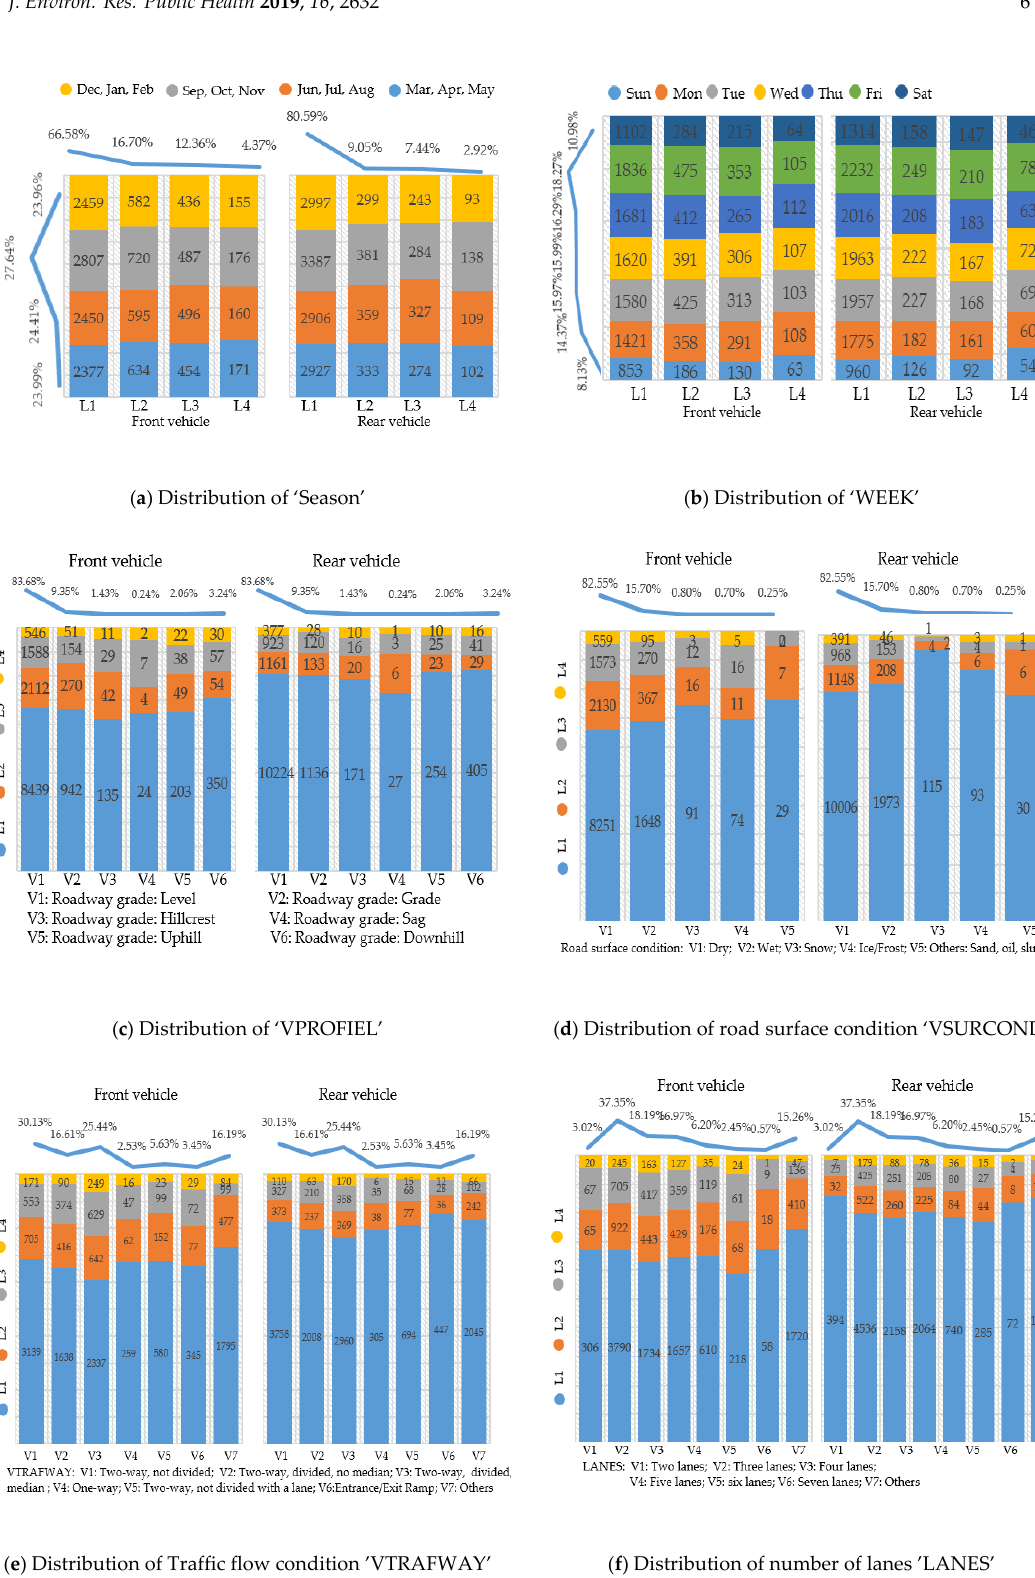
Figure 1. Summary statistics for driver-related, vehicle-related and other independent variables.